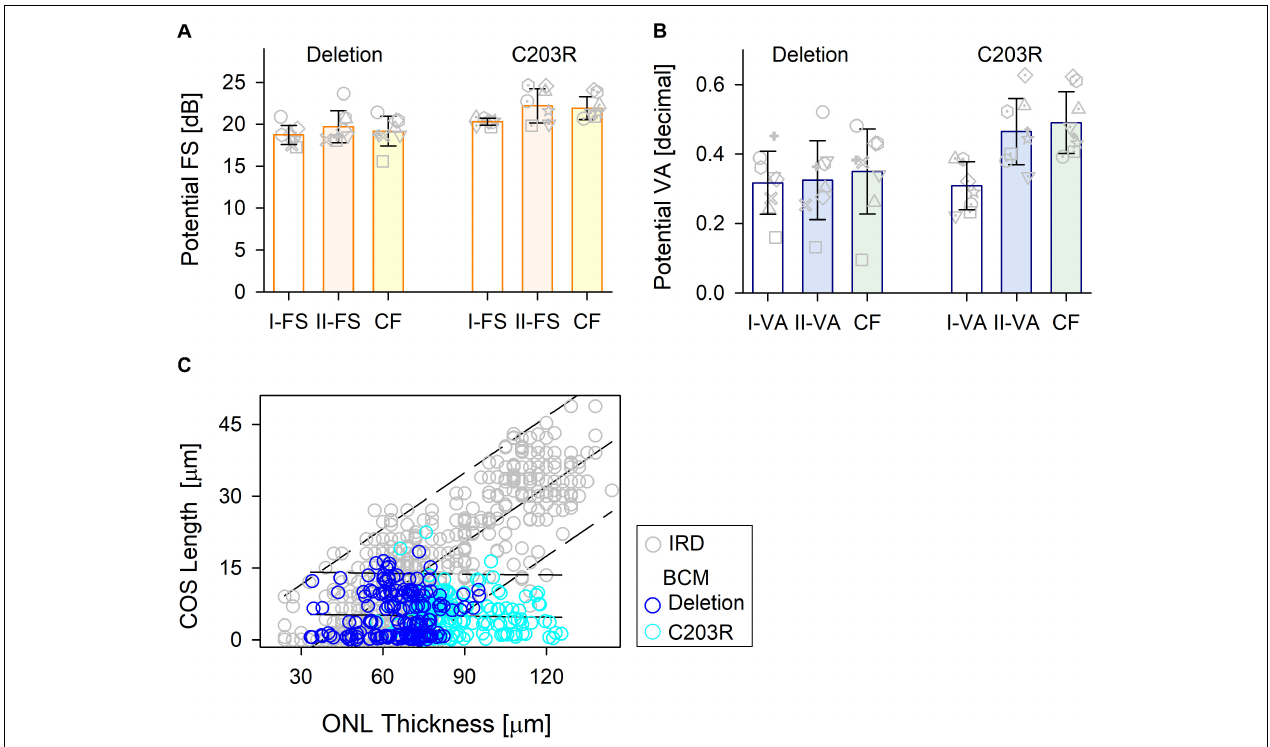
FIGURE 5 | Comparison of the treatment potential (difference between prediction and measured values) for the three methods in the two BCM genotypes. (A) Treatment potential for FS in deletion mutations and C203R mutation patients. Model 1, white bar; Model II, light orange bar; CF, light yellow bar. (B) Treatment potential for VA in the two groups. Model 1, white bar; Model II, light blue bar; CF, light green bar. Individual subjects, gray unfilled symbols; error bars, standard deviation. (C) Relation between ONL thickness and COS length for IRD patients used in the training set (gray circles) and those for BCM patients (deletion, dark blue circle; C203R, cyan